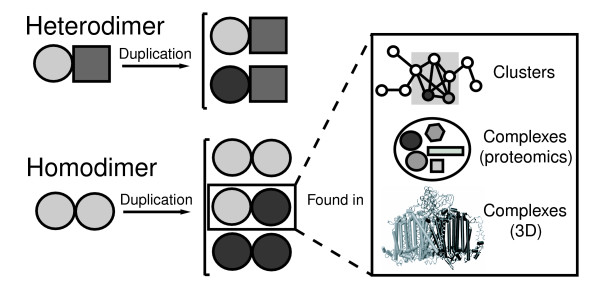
A hypothesis for the origins and evolution of protein complexes. Gene duplication with conservation of protein interactions is frequent [9]. Self-interactions (homomeric interactions) have special structural properties (see text for details) that are conserved into the duplicated interaction between paralogous proteins (light-dark interaction). Interactions between paralogous proteins are more versatile functionally and structurally, and are systematically selected for in evolution. These interactions are central in the establishment and evolution of clusters in PINs and protein complexes.